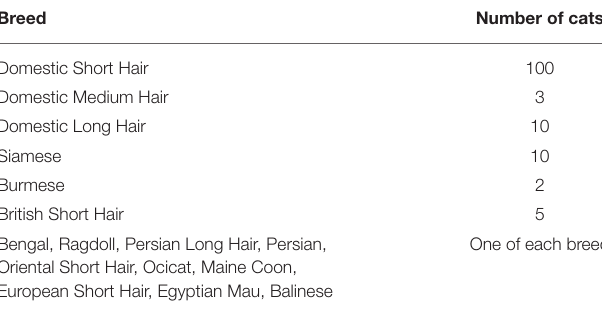
TABLE 1 | Distribution of breeds for study cats ( N =